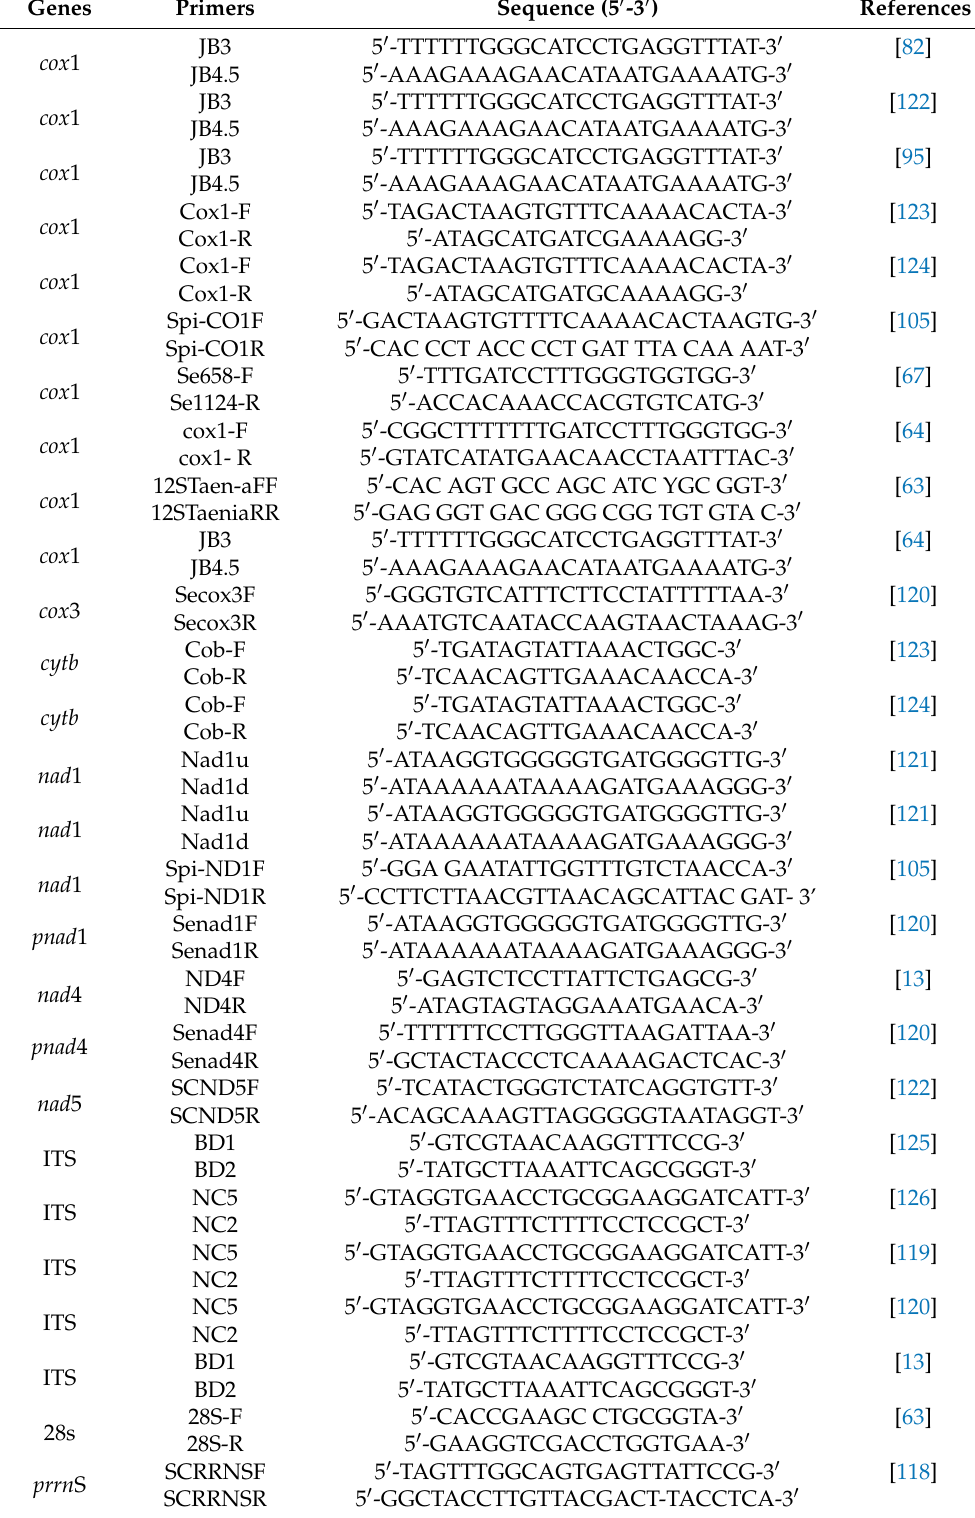
Table 5. S. erinaceieuropaei molecular diagnosis.